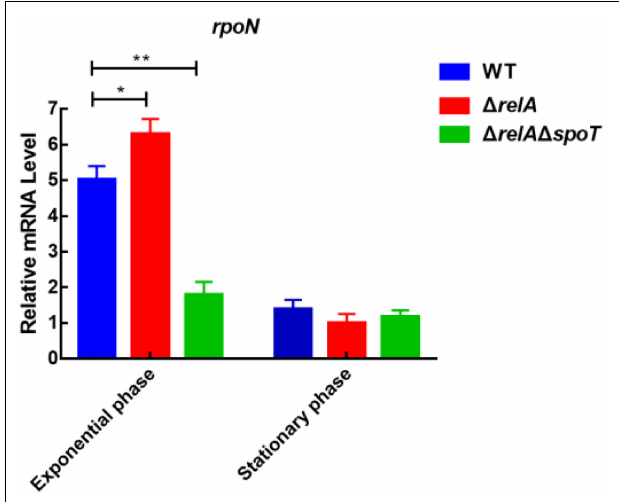
FIGURE 7 | The relative mRNA levels of rpoN was detected by qRT-PCR in WT, (cid:49) relA , and (cid:49) relA (cid:49) spoT at low and high densities, respectively. The results are normalized to the control gene 16S rRNA using the 2 − (cid:49)(cid:49) Ct method. Results are shown as the means ± SD ( n = 3). The blue columns, red columns, and green columns represent WT, (cid:49) relA , and (cid:49) relA (cid:49) spoT , respectively. * indicates p ≤ 0.05, and ** indicates p ≤